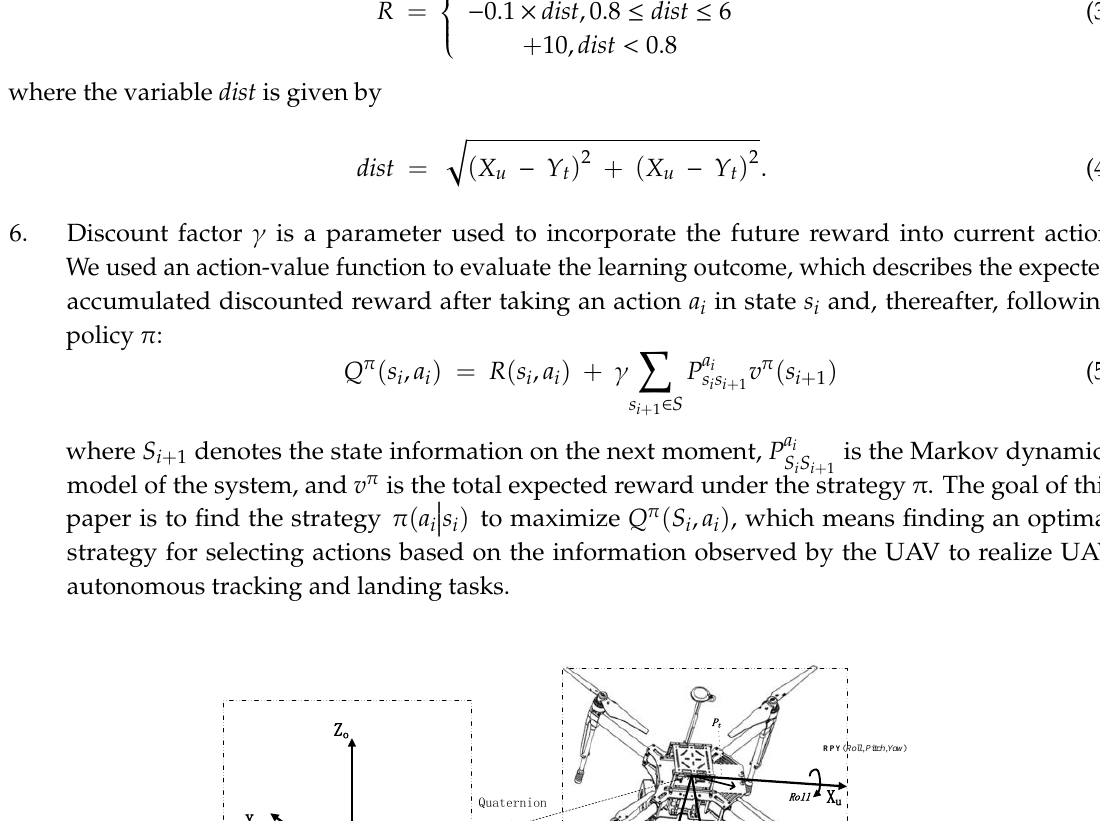
Figure 2. At each moment, the UAV sequential decision process can be divided into three steps: obtaining state information of the current system, performing actions, and updating the state.